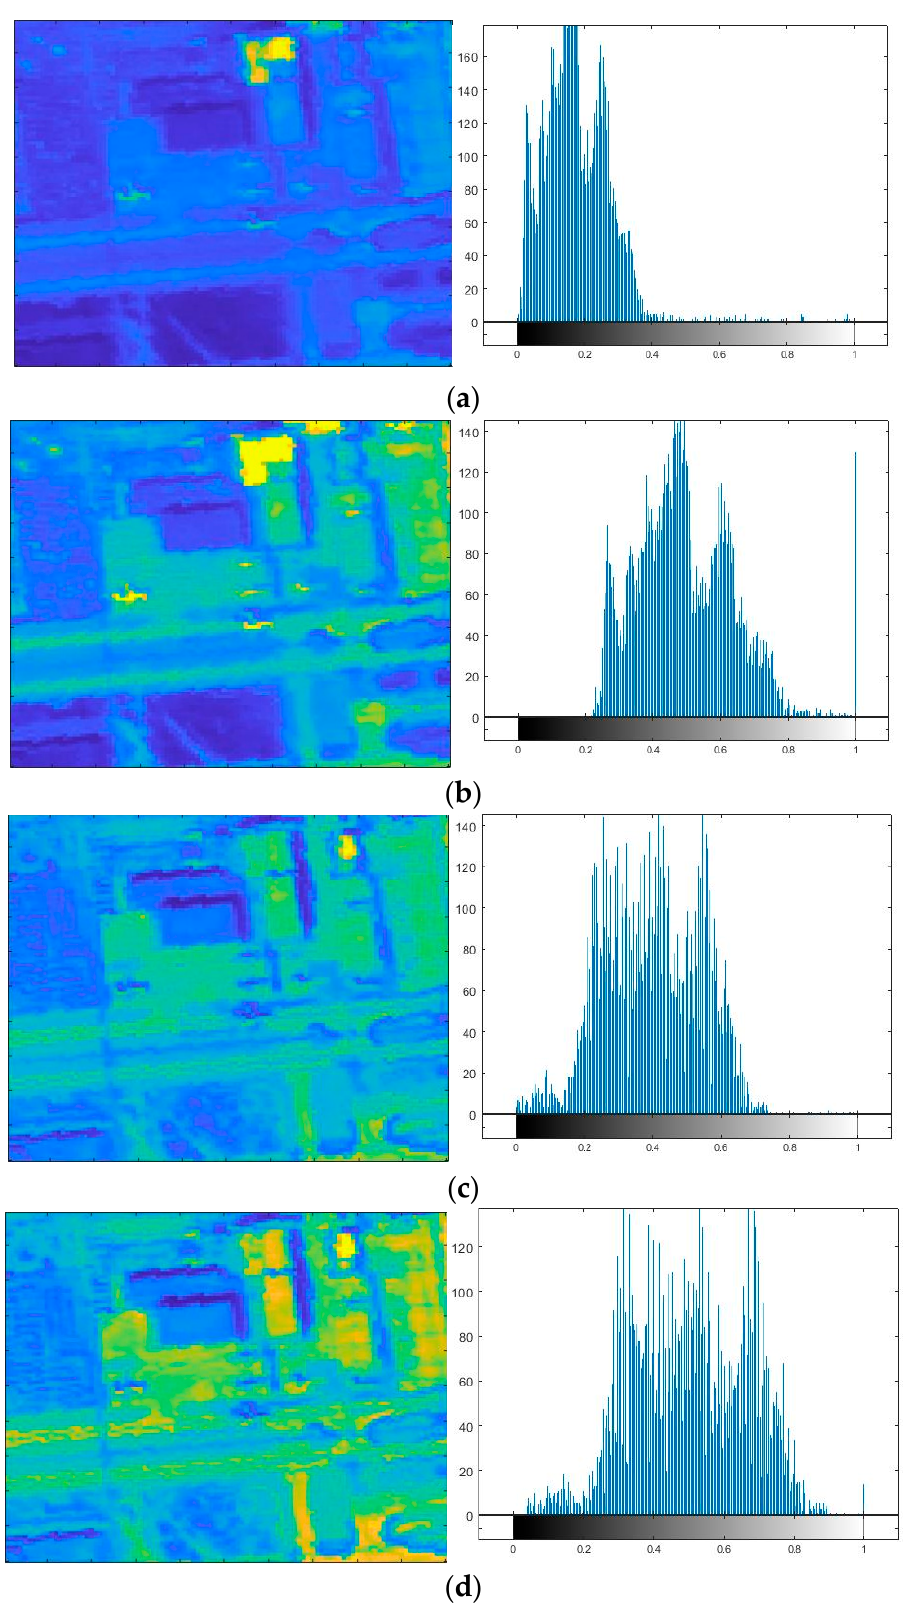
Figure 2. Image and image histogram of ( a ) ABU-Airport-1 band 5 before normalization and ( b ) after normalization; and ( c ) band 165 before normalization and ( d ) after normalization. The histograms show the grayscale values (in the range of 0–1) in the 𝑥 -axis, and the number of pixels (counts) in the 𝑦 -axis.